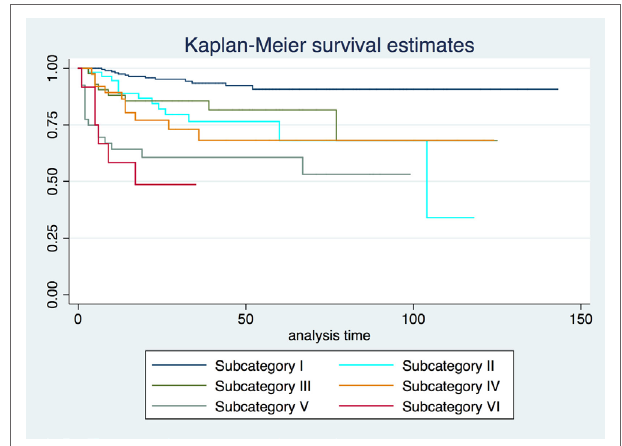
FigUre 1 | Recurrence-free survival Kaplan–Meier curves for each